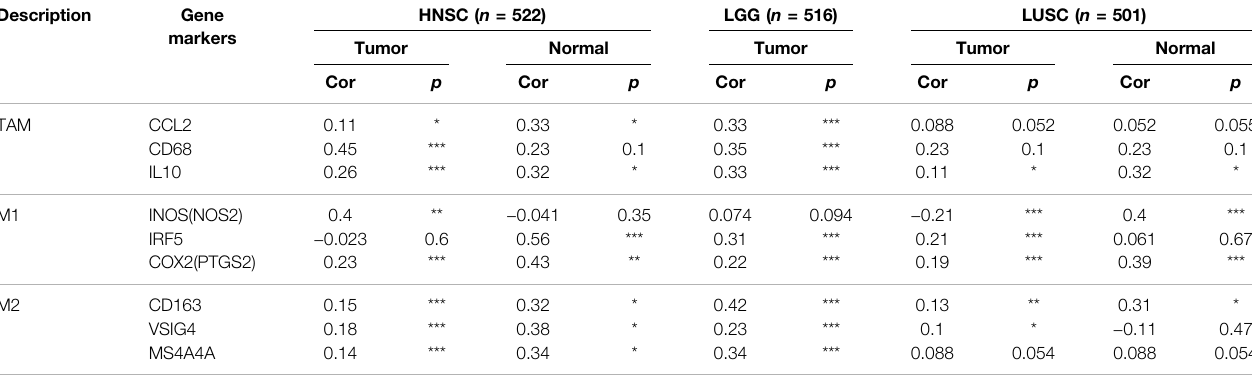
TABLE 3 | Correlations between SHC1 and gene markers of immune cells in GEPIA. Description Gene markers Tumor Normal Tumor Tumor